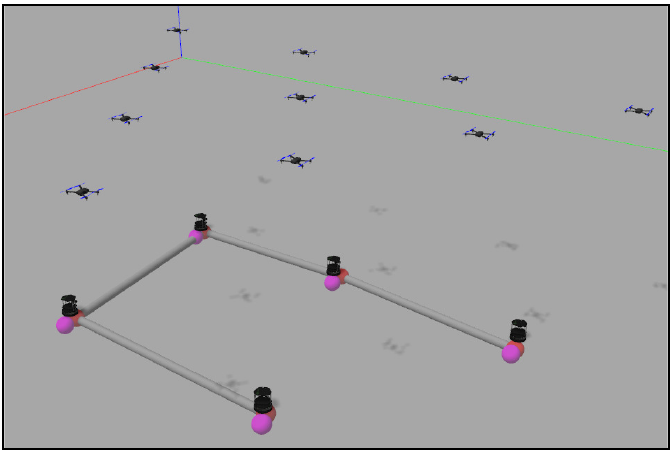
Figure 16. Final layout in a formation-tracking experiment.